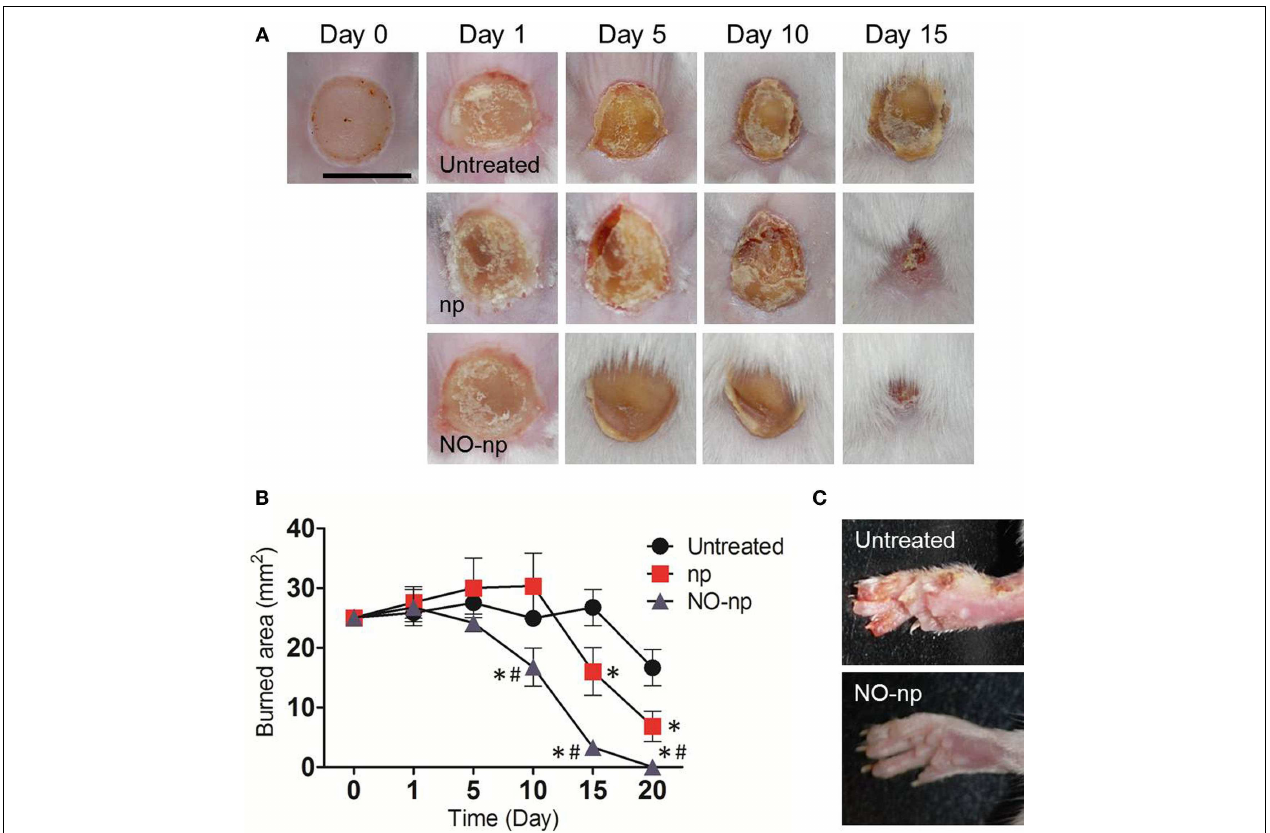
of six different wounds, and error bars denote SDs. * P < 0.001 in comparing the np- or NO-np-treated group with untreated group. # P < 0.001 in comparing the np-treated group with the NO-np-treated group.These experiments were performed twice with similar results. (C) NO-np prevents cutaneous spread of candidiasis in mice.Three animals per group per time point were